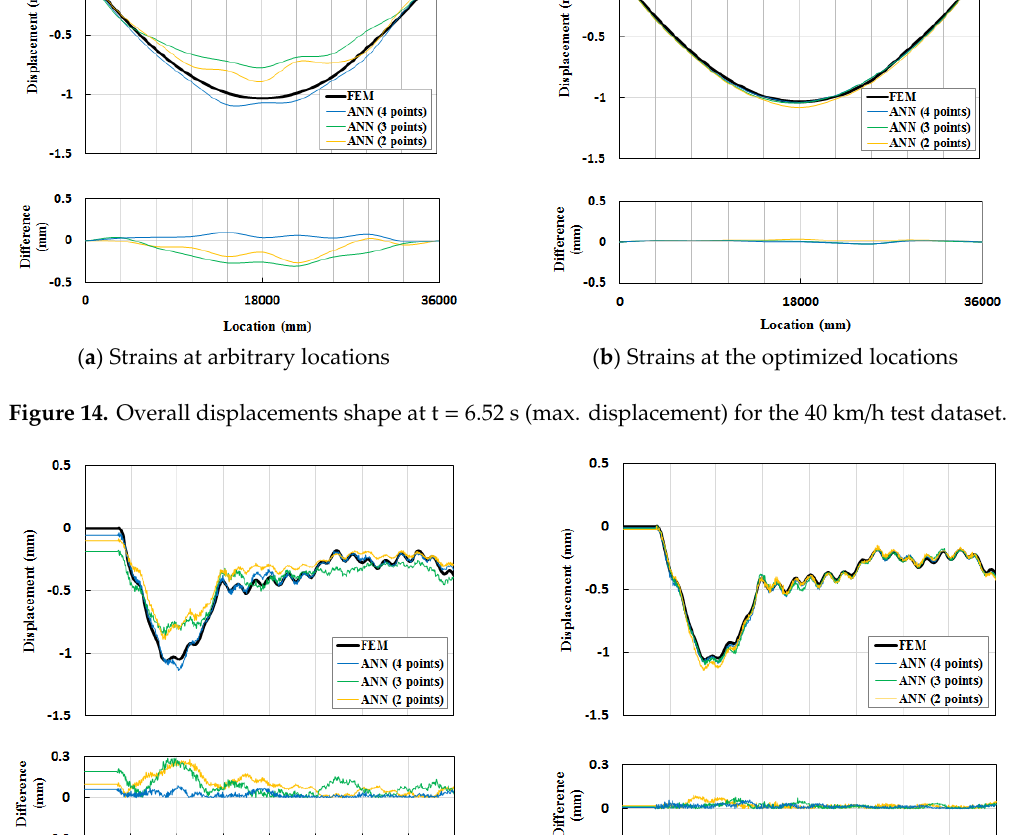
Figure 13. Displacements over time at center girder for 40 km/h test dataset.